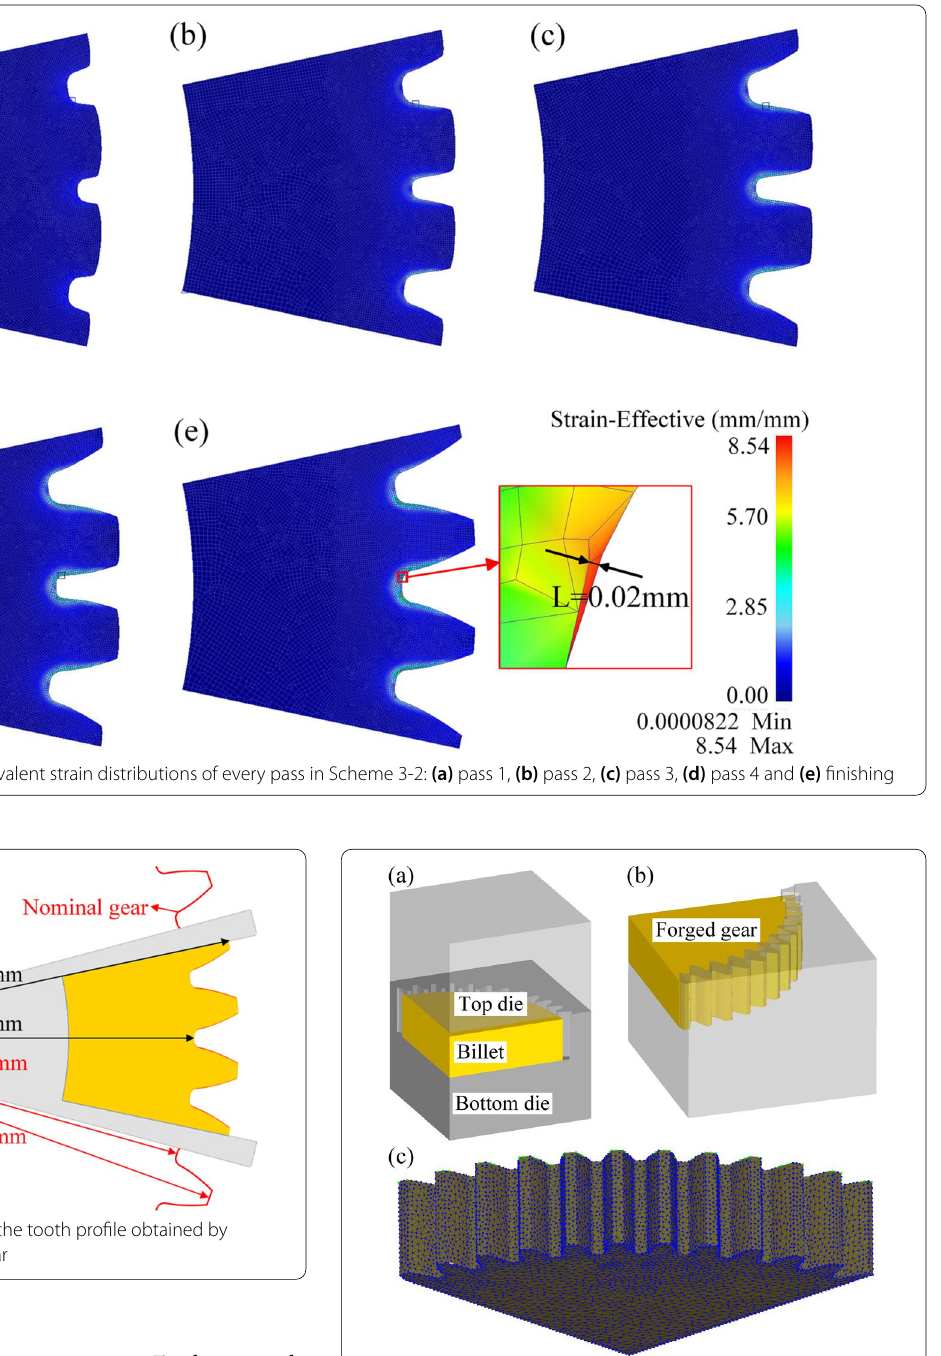
and shrinkage allowance, and will be removed in the later machining process to obtain the accurate tooth profile.